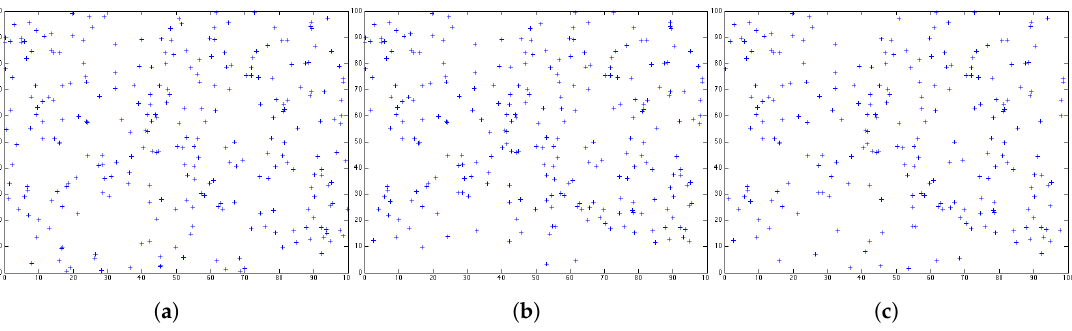
Figure 5. Sensor distribution after 450 rounds using LEACH, HEED and BEE. ( a ) LEACH; ( b ) HEED; ( c )